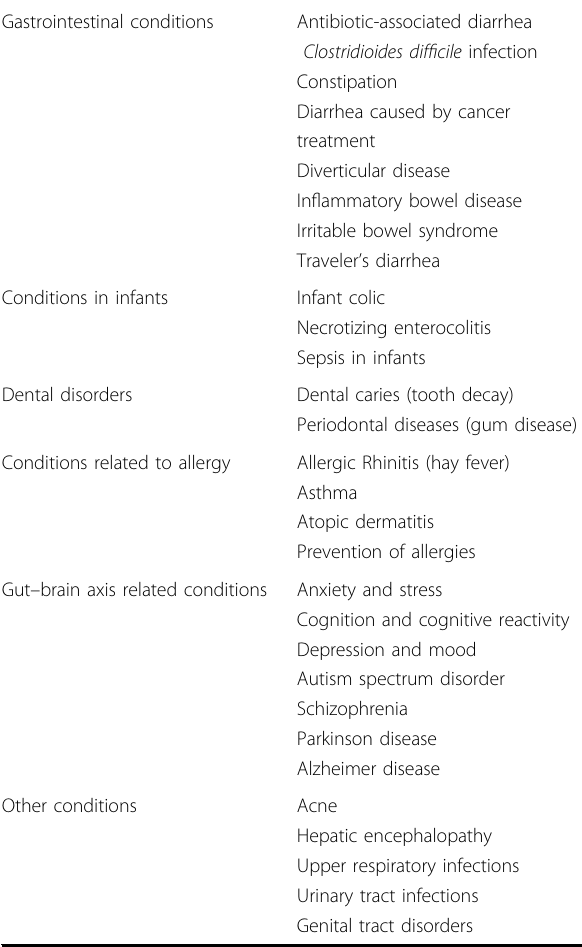
Table 1 Modi fi ed list of NIH-mentioned application fi elds for